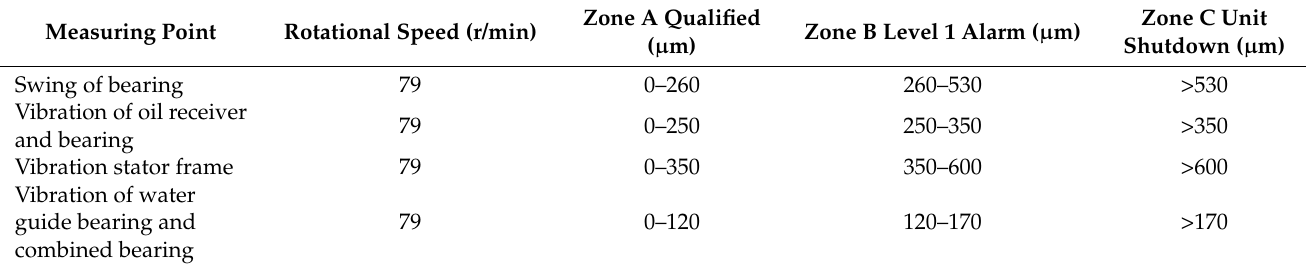
Table 7. Vibration swing alarm threshold of monitoring system of hydropower station. Measuring